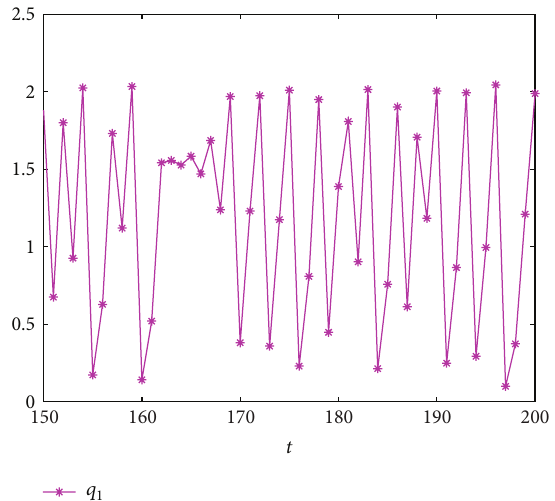
Figure 17: The wave plots of the output 𝑞 1 with the change of time when 𝛼 1 = 1.02 , 𝛼 2 = 1.46 and 𝜃 = 0.976 .